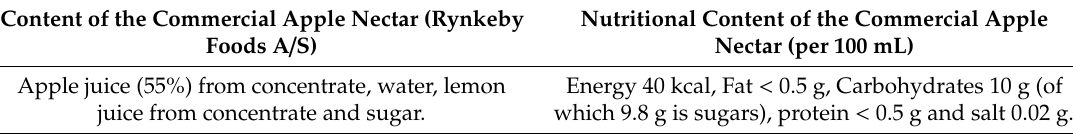
Table 2. Lists of content of the commercial apple nectar used as a base product. Content of the Commercial Apple Nectar (Rynkeby Nutritional Content of the Commercial Apple Foods A / S) Nectar (per 100 mL) Apple juice (55%) from concentrate, water, lemon juice from concentrate and